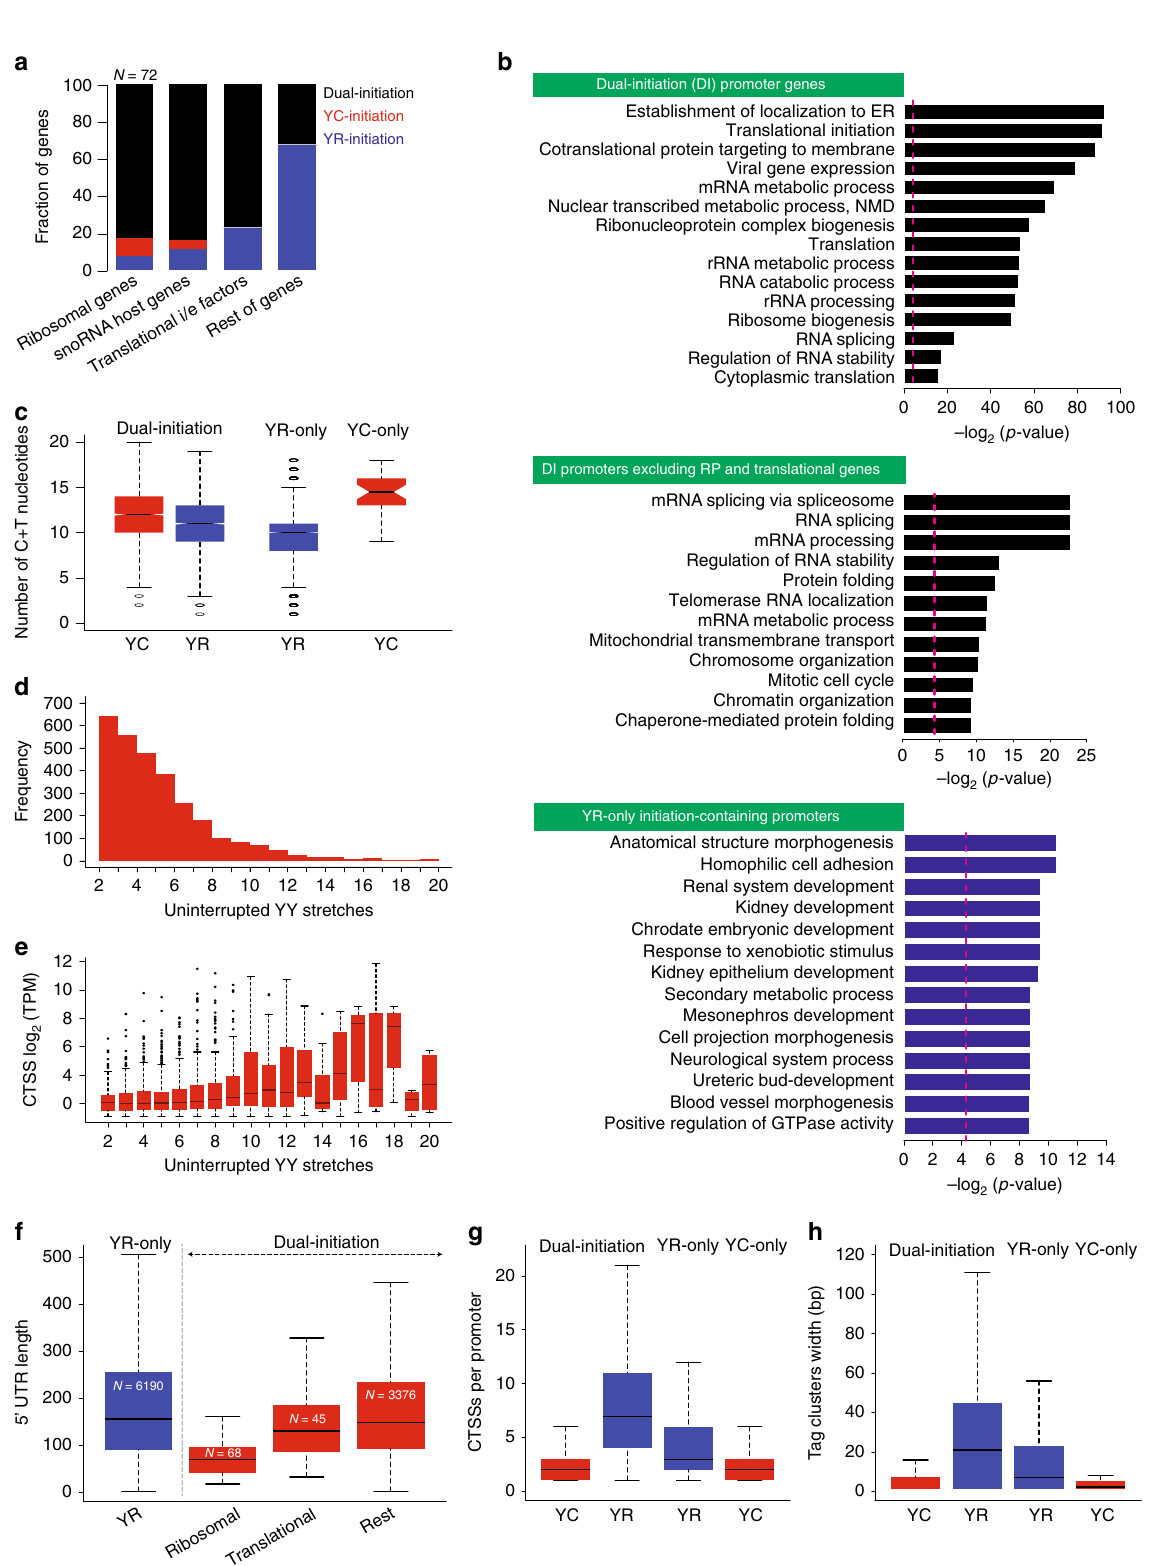
gene-families revealed that most of these genes carry dual-initiation sites (Fig. 2a). Gene ontology (GO) analysis of DI promoter genes revealed an enrichment of translation machinery components (translation, translation elongation, and translation termination), co-translational proteins targeted to membrane, RNA stability and nonsense mediated decay (Fig. 2b;